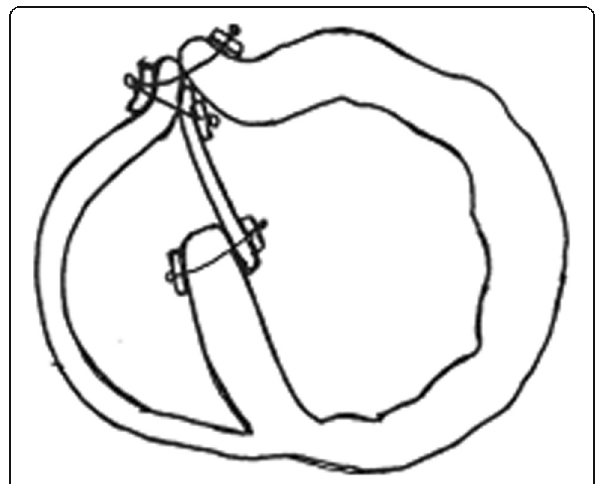
Fig. 2 Daggett ’ s infarctectomy and septal rupture reconstruction